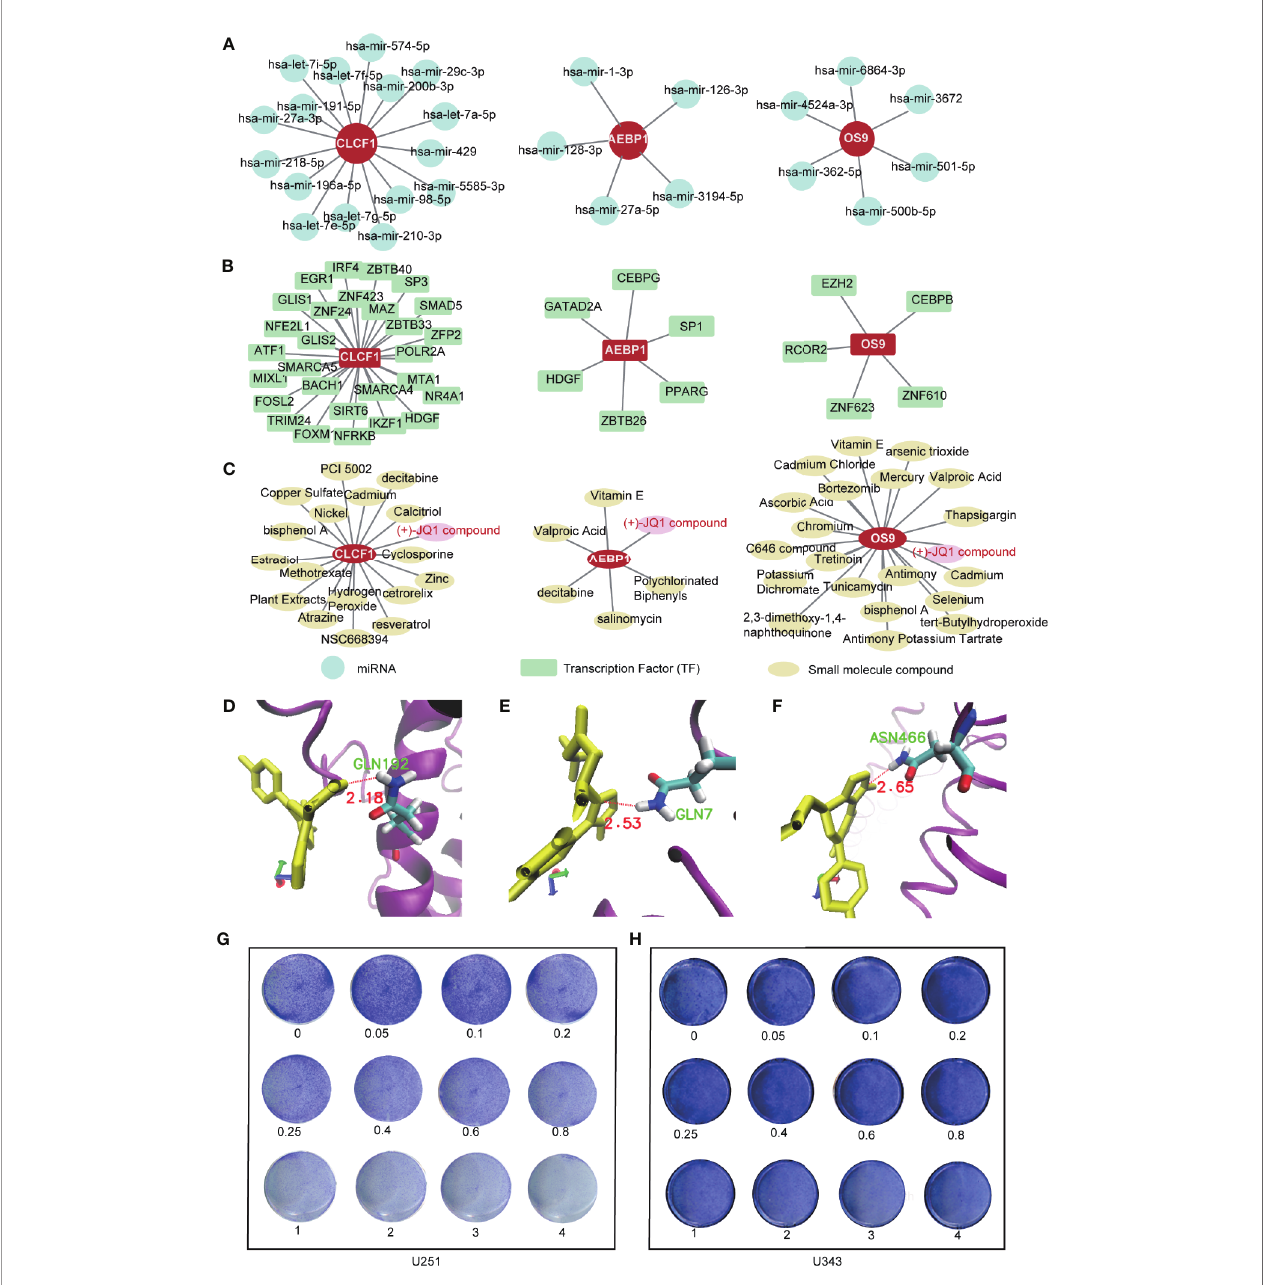
FIGURE 6 | Targeted treatment for PTEN-mut glioma: (A) The miRNA-gene network of CLCF1 , AEBP1 and OS9 by NetworkAnalyst (Materials and methods 2.6); (B) The TFs-gene network of CLCF1, AEBP1 and OS9 by NetworkAnalyst (Materials and methods 2.6); (C) The protein-chemical network of CLCF1, AEBP1, and OS9 by NetworkAnalyst (Materials and methods 2.6); (D – F) The docking site between CLCF1, AEBP1, OS9 with (+)-JQ1 by Autodock (Materials and methods 2.7); (G) Colony formation assay was performed in U251(PTEN- de fi ciency) cells treated by (+)-JQ1 with different concentration (Materials and methods 2.8); (H) Colony formation assay was performed in U343 cells treated by (+)-JQ1 with different concentration ( Materials and Methods 2.8